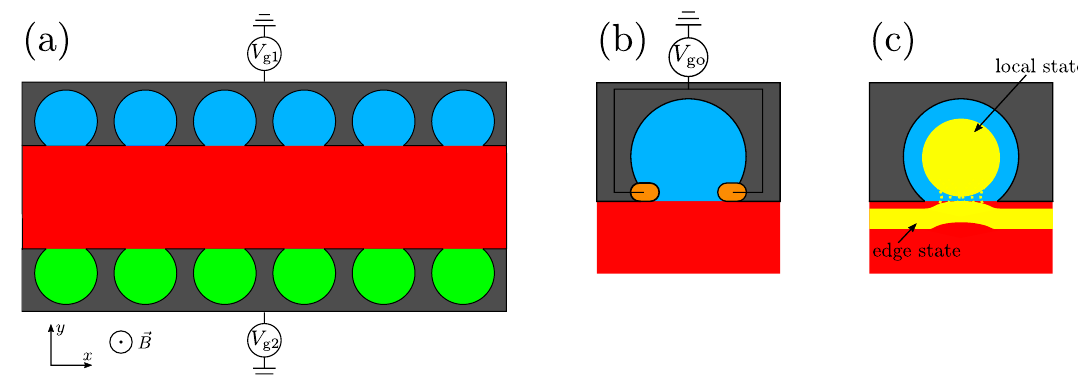
Figure 1: Panel (a): proposal of a decorated quantum Hall sample with tunable Fermi velocity. A perpendicular magnetic field puts the two-dimensional electron gas in the quantum Hall phase. Two independent gate voltages V and V change the potential of the blue bays at g1 g2 the upper boundary and of the green bays at the lower boundary, respectively. The grey area is inaccessible to the electrons. The size of the opening of the bays to the bulk 2DEG can be controlled by a gate voltage V as depicted in panel (b). The size of the opening controls the go degree of hybridization of the local mode within the bays and the edge mode in the 2D bulk, see panel